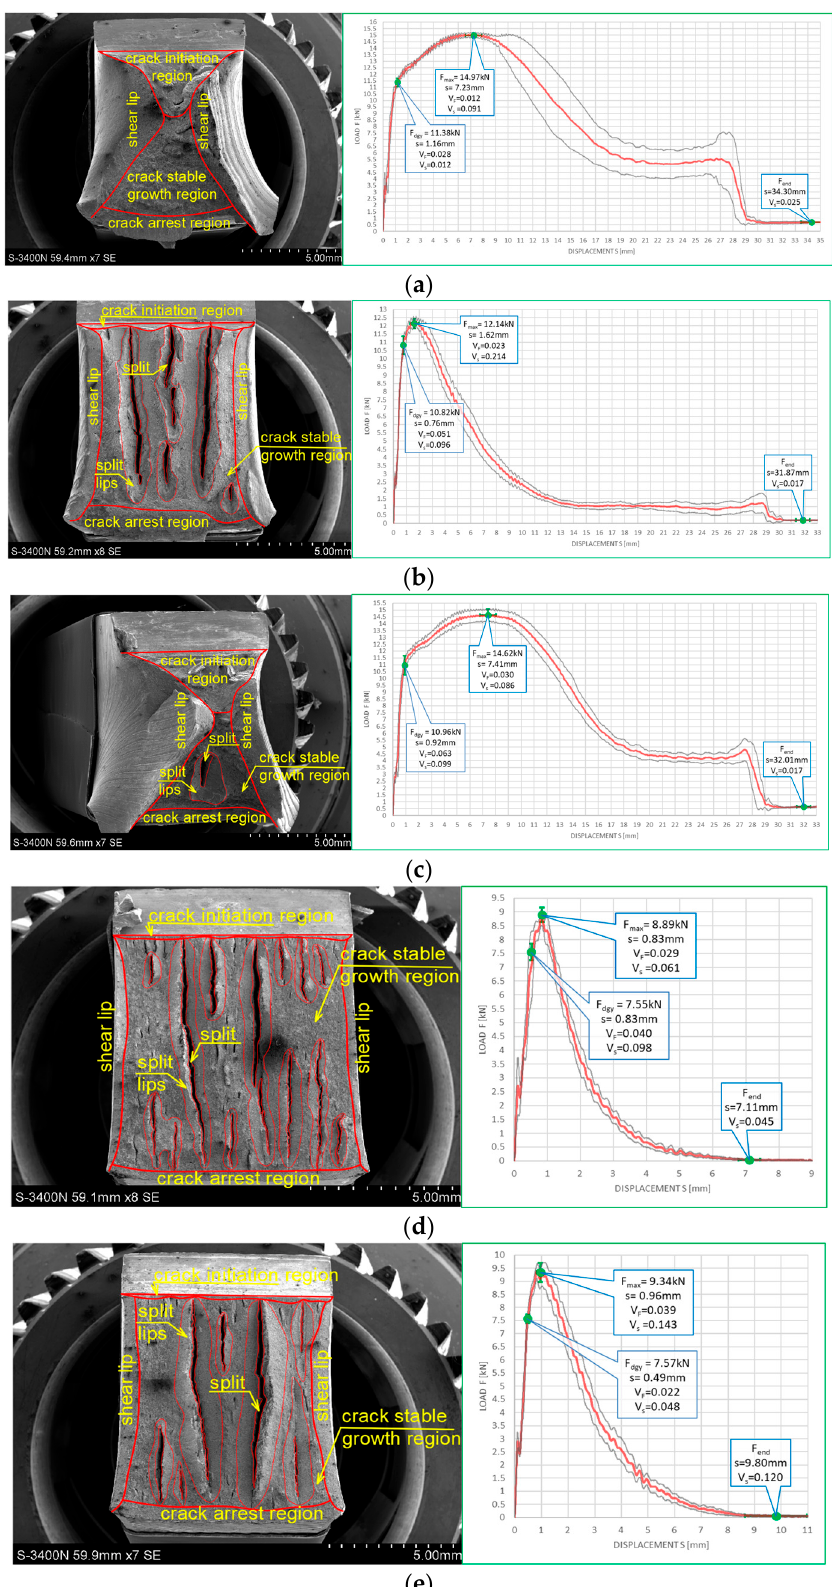
Figure 23. Morphology of the impact fractures obtained during the tests conducted at − 20 °C on the samples made of X2CrNiMoN22-5-3 steel—denotations follow the key listed in Table 1. ( a ) 4 ( − 20) ; ( b ) 460 ( − 20) ; ( c ) 461 ( − 20) ; ( d ) 480 ( − 20) ; ( e ) 481 ( − 20) .